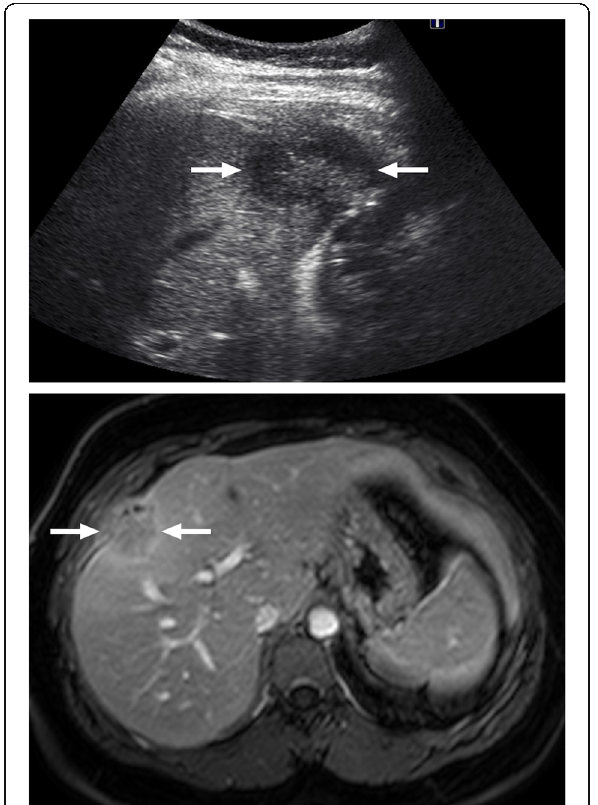
Fig. 2 A 37-year-old female with no known systemic disease presented with right upper quadrant pain. a Abdominal ultrasound demonstrates hypoechoic solid mass lesion with slightly increased central echogenicity (arrows). b Axial plane postcontrast T1W image demonstrates peripherally enhancing infiltrative sub-capsular mass lesion (arrows) extending into perihepatic area and infiltrating abdominal wall fat. Also note associated peritoneal thickening. Percutaneous US-guided biopsy revealed granulomatous inflammation consistent with tuberculoma